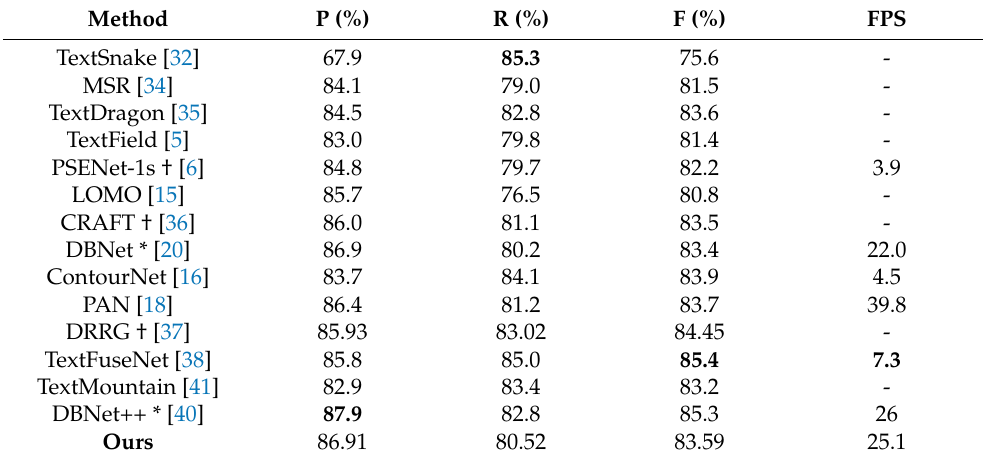
Table 4. Detection results on the CTW1500 dataset. “*” indicates using deformable-ResNet-50 as backbone and “†” indicates using external MLT17 data for pre-training. The best performance is given in